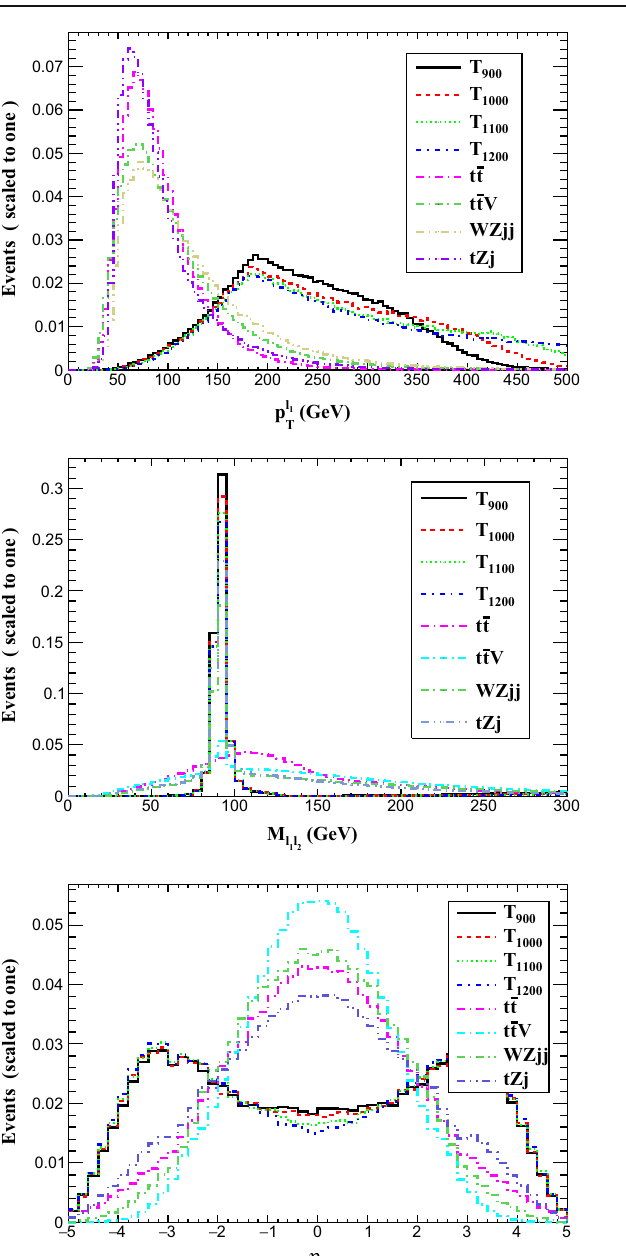
√ T → bW decay channel at s = 14 TeV with 30 fb − 1 of tion discussed in Ref. [114], the production cross sections of ∼ 70–140 (30–65) fb for m = 1 ( 1 . 5 ) TeV, respectively, σ integrated luminosity, obtaining an expected exclusion reach T T could be discovered at the LHC with 100 fb − 1 . Similarly, the for masses up to 1.0 TeV, including both pair and single pro- cross sections of σ T ∼ 27–60 (13–24) fb for m T = 1 ( 1 . 5 ) duction. For two typical top-partner masses, m T = 1 . 0 ( 1 . 5 ) TeV, the authors in Ref. [114] studied the search strategies of TeV, respectively, can be excluded. Therefore, our analysis is the single top-partner production with all the possible decay competitive with the results of the existing literature and rep- √ s = 14 TeV. modes (i.e., t Z , th and Wb ) at the LHC for resents a complementary candidate to search for a possible The results show that, for the specific model implementa- singlet top